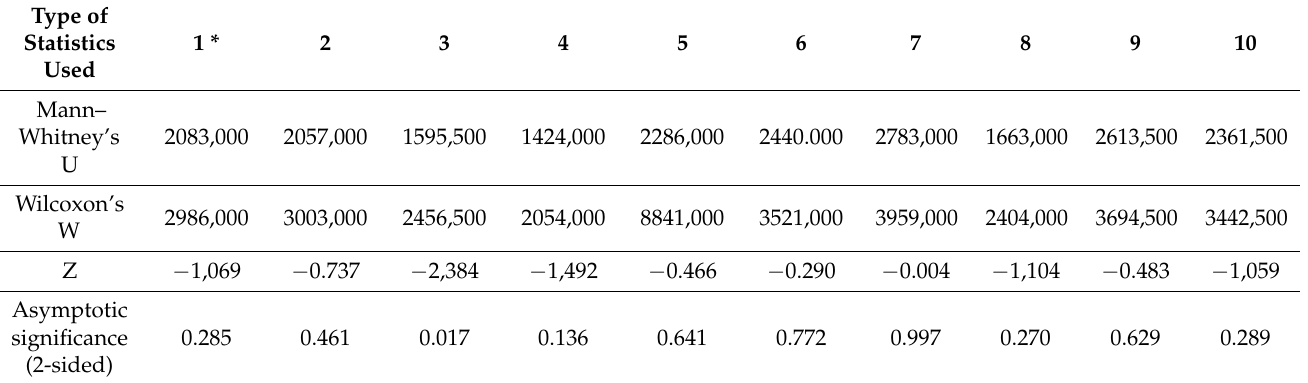
Table 3. Preference for a particular type of onboarding and the respondents’